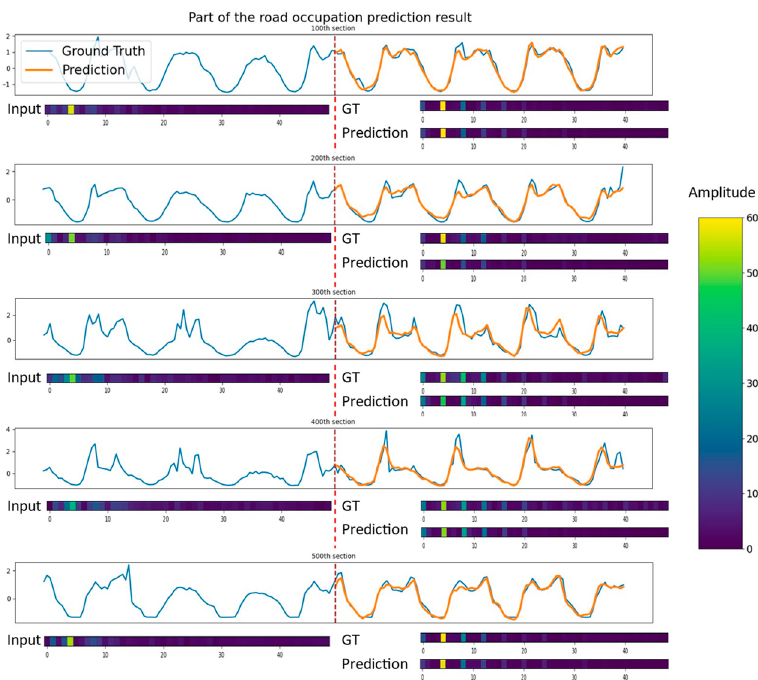
Figure 5. Part of the test set prediction results for sensors 100~500. The curves are the prediction results of each sensor. The “Input”, “GT”, and “Prediction” below each curve correspond to the frequency domain representation of the input time series, the ground truth series, and the model prediction result. The core frequency components are accurately captured by our model, especially the low-frequency components with large amplitude.